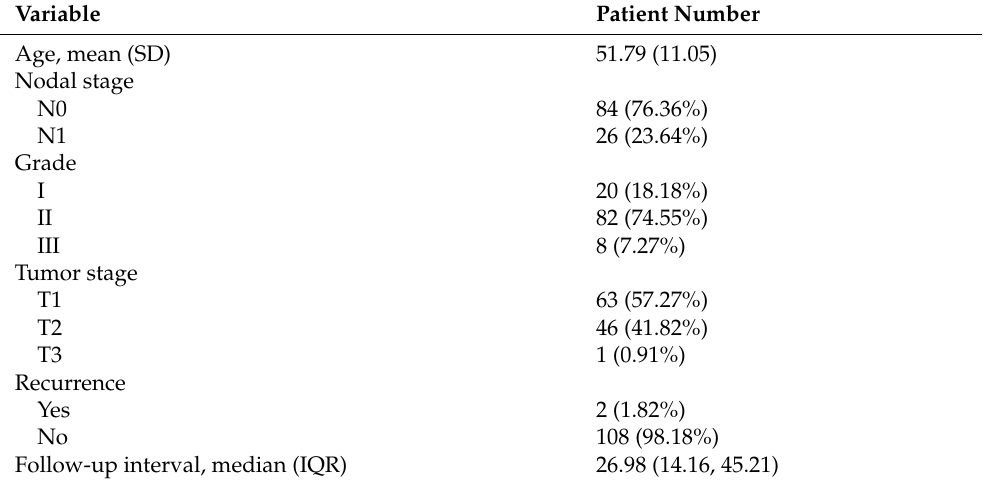
Table 1. Characteristics of the study population (N =